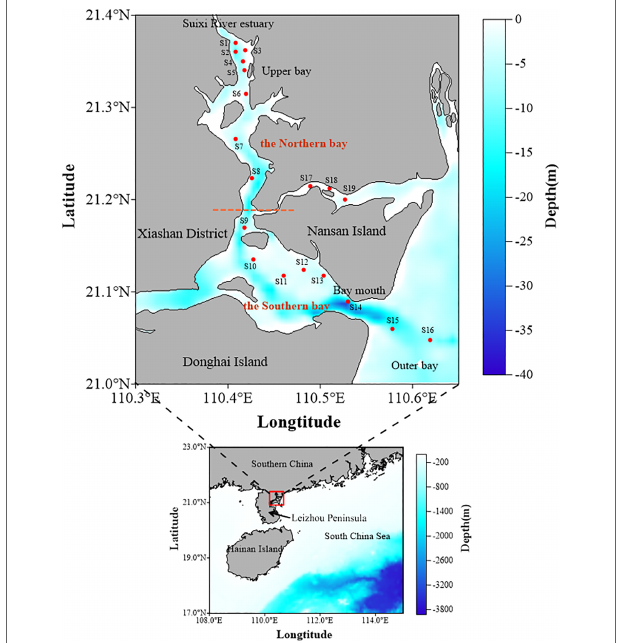
FIGURE 1 | Map of Zhanjiang Bay and sampling sites